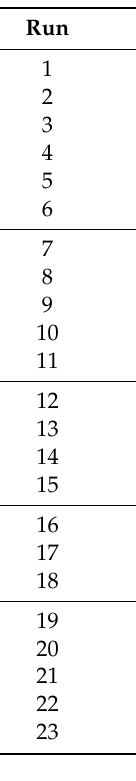
Table 1. Experimental planning: runs carried out under di ff erent operating conditions (biomass concentration and agitation) employing both shake flasks (runs 1 to 18) and stirred tank bioreactor (STBR) (runs 19 to